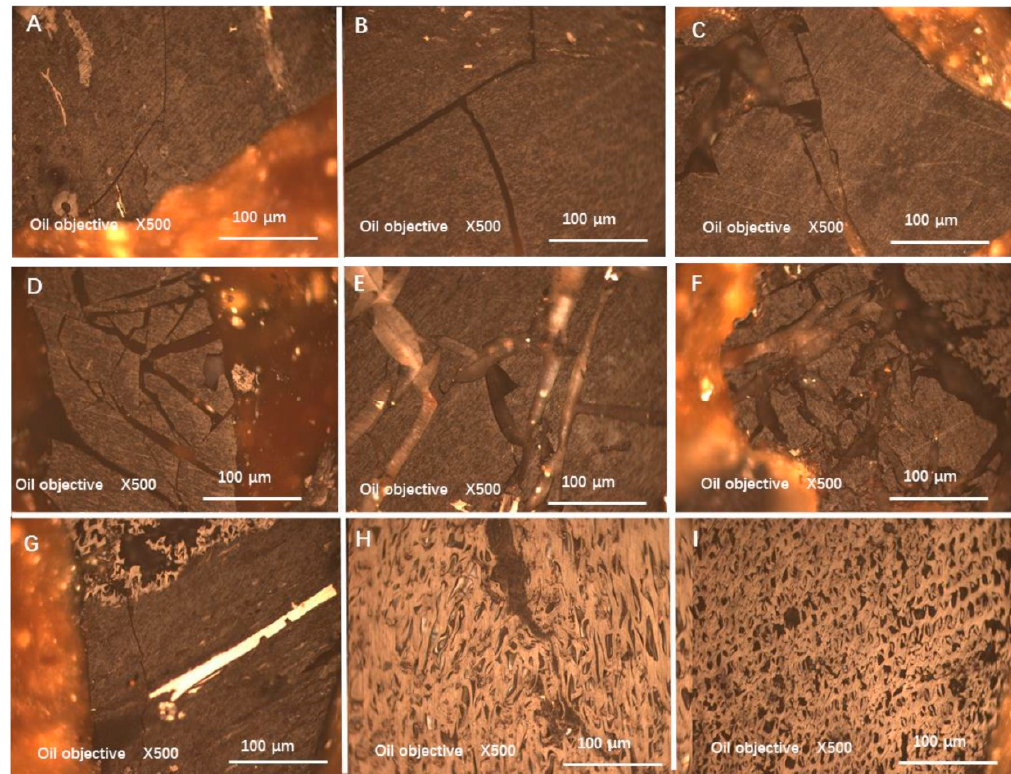
Figure 6. Broken characteristic images of macerals from coal. ( A ) Broken characteristics of vitrinite from coal with a particle size greater than 0.9 mm; ( B , C ) broken characteristics of vitrinite from coal with a particle size between 0.5 and 0.9 mm; ( D , E ) broken characteristics of vitrinite from coal with a particle size between 0.1 and 0.5 mm; ( F ) broken characteristics of vitrinite from coal with a particle size less than 0.1 mm; ( G ) broken characteristics between vitrinite and inertinite from coal with a particle size between 0.5 and 0.9 mm; ( H ) broken characteristics between vitrinite and inertinite from coal with a particle size between 0.5 and 0.9 mm; and ( I ) broken characteristics between vitrinite and inertinite from coal with a particle size greater than 0.9 mm.